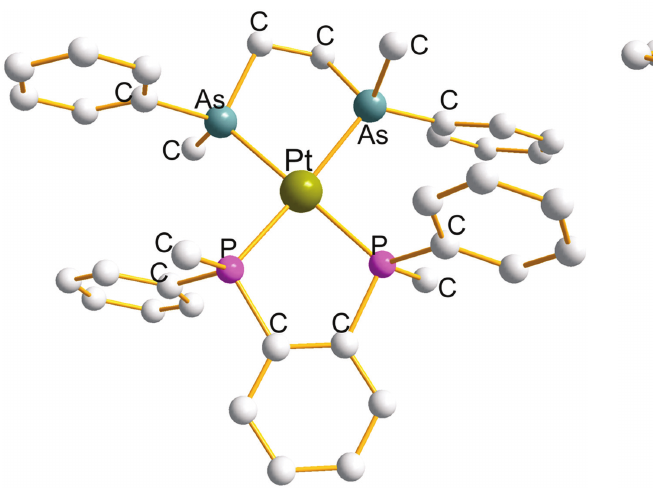
Figure 2: Structure of [Pt{η 2 -Me et al., 2009).